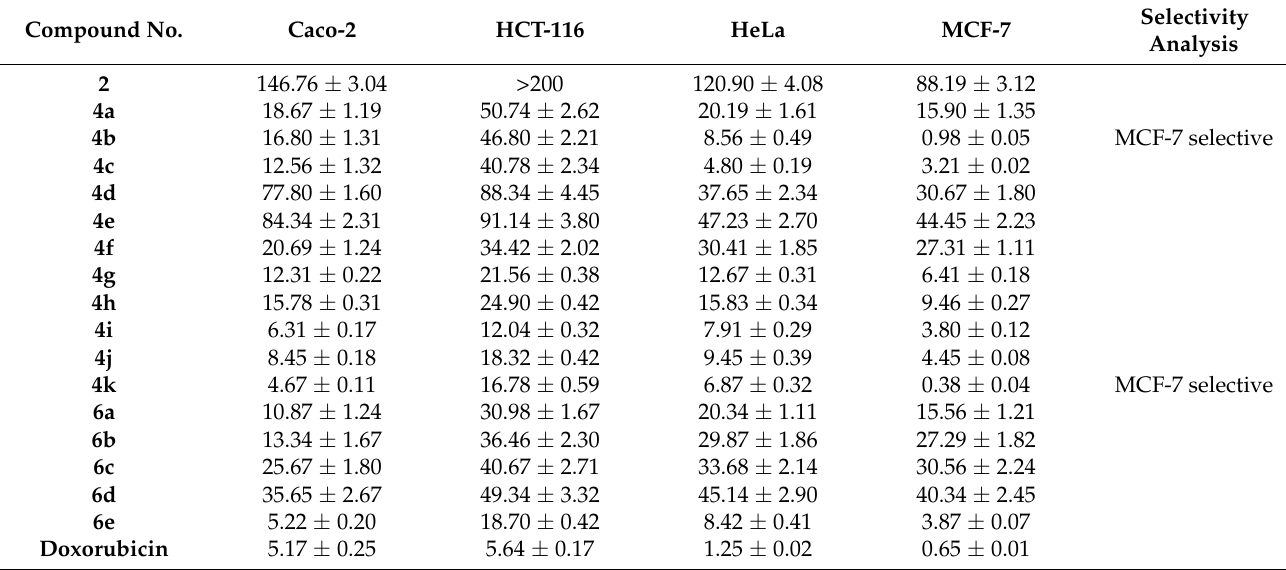
Table 1. Anticancer screening of the synthesized compounds expressed as IC 50 (μM) using the MTT assay. IC 50 values are expressed as the mean ±SD of three independent experiments.